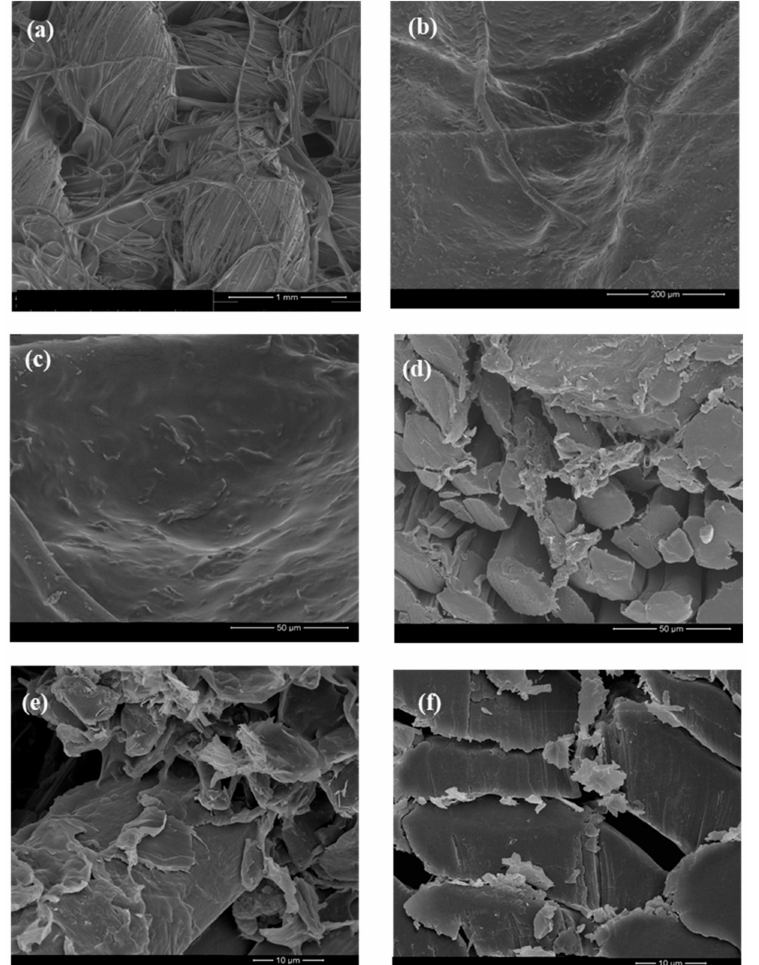
Figure 6. FESEM images of the ecocomposites surface with 2% of GNPs using di ff erent magnifications: ( a ) 1 mm, ( b ) 200 µ m, and ( c ) 50 µ m and cross section images using 50 µ m ( d ) and 10 µ m ( e ) and ( f ) in di ff erent zones of the sample.